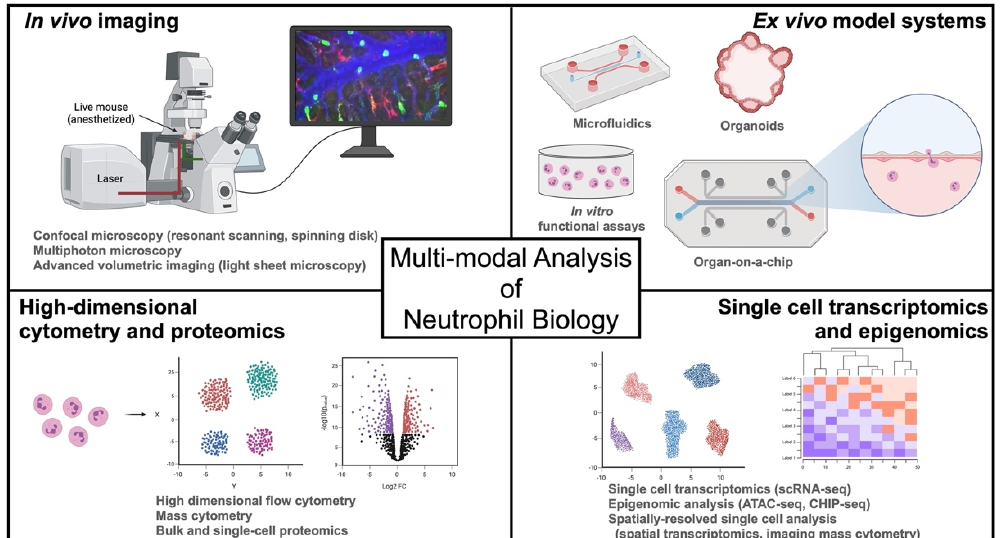
Figure 1. Overview of a multi-modal approach to the study of neutrophils in cancer and beyond. Intravital microscopy is a powerful tool to characterize in vivo cell biology of neutrophil trafficking and function in tissues. Ex vivo assays like laminar flow chambers, microfluidics, and in vitro functional assays, together with emerging technologies of organoids and organs-on-a-chip, are used to understand the dynamic functions of human neutrophils. Deep characterization of neutrophil heterogeneity, plasticity, and functional regulation are facilitated by high-dimensional transcriptomic, epigenomic, and proteomic methodologies, which can also enable a systems biology approach to the study of neutrophils in vivo.